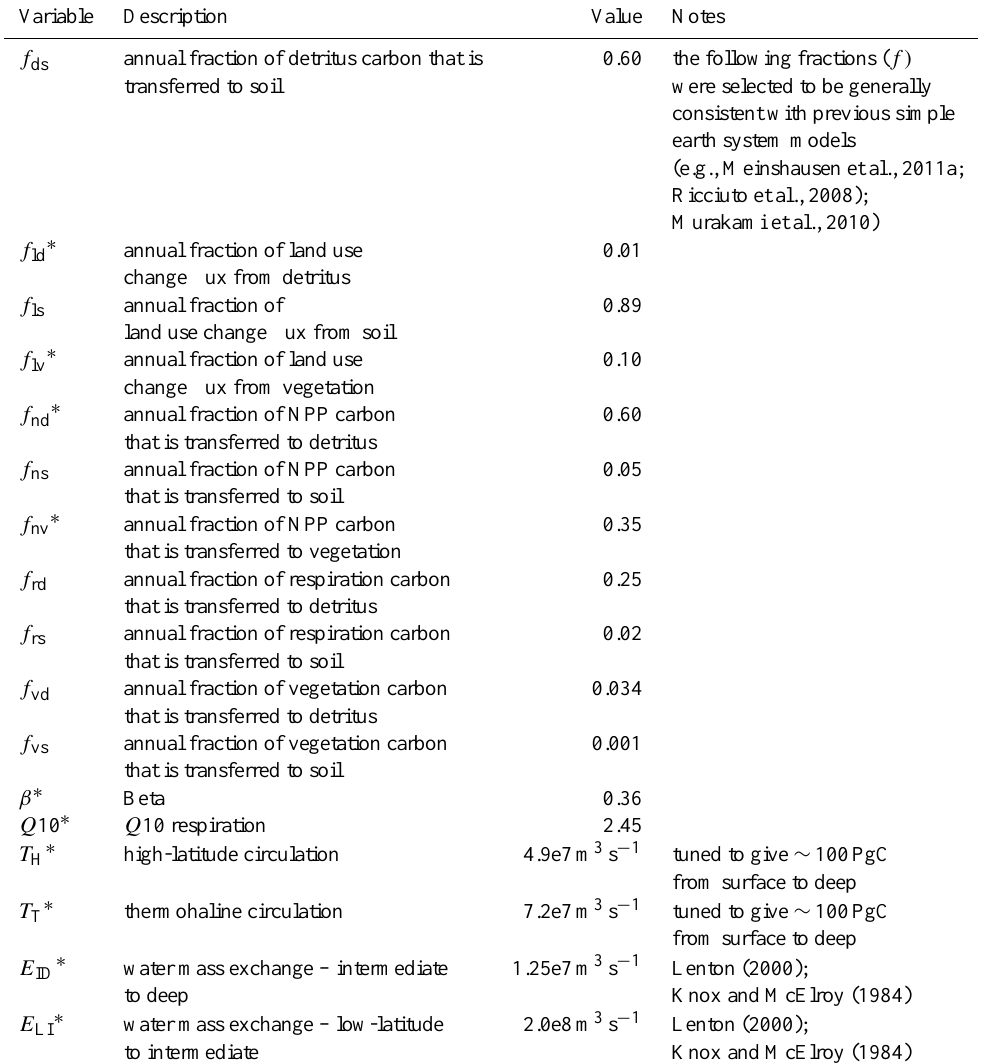
Table 2. Model parameters for the land and ocean carbon components. Variable Description Value Notes f ds annual fraction of detritus carbon that is 0.60 the following fractions ( f ) transferred to soil were selected to be generally